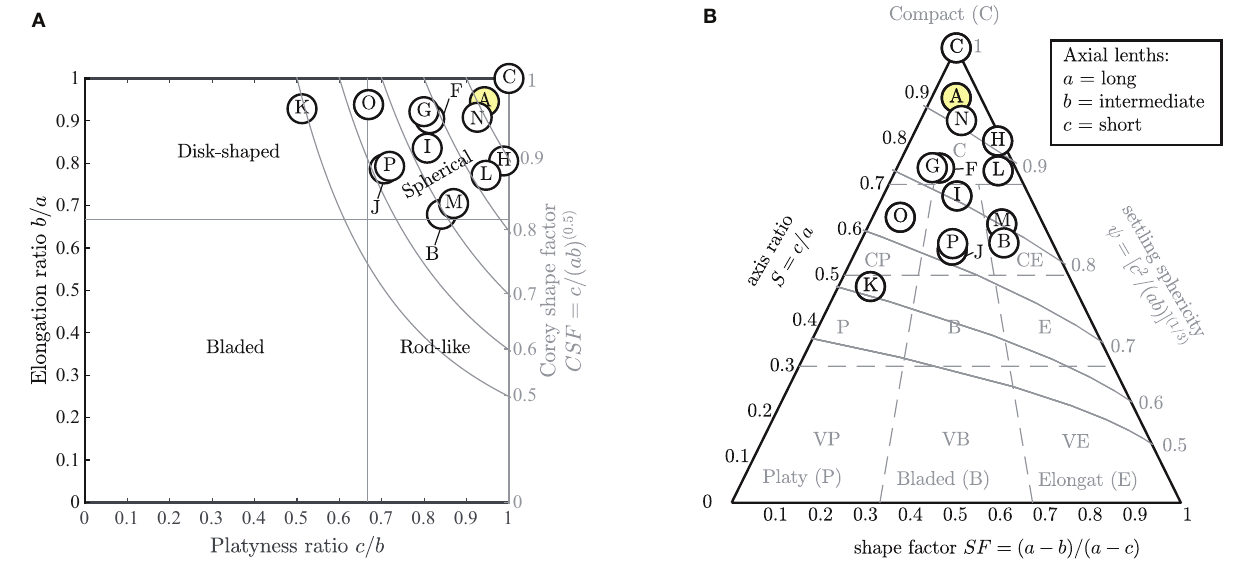
FIGURE 4 | Shape parameter of the tested MPs including the surrounding grain (sample “A,” yellow shaded). (A) Relation between axes ratio and particle shape (Zingg’s classification) (Krumbein, 1941) and sphericity classification (Corey, 1949). (B) Sphericity-form diagram with relation between axis ratio, shape factor, and settling sphericity (Sneed and Folk,